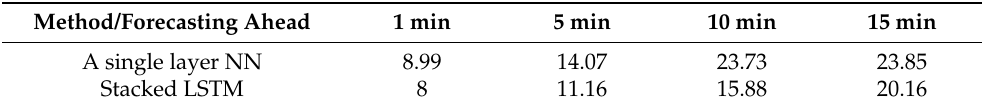
Table 3. MAE between the actual and predicted coarse return on the test dataset in long short-term memory (LSTM) and single hidden layer neural network (NN)